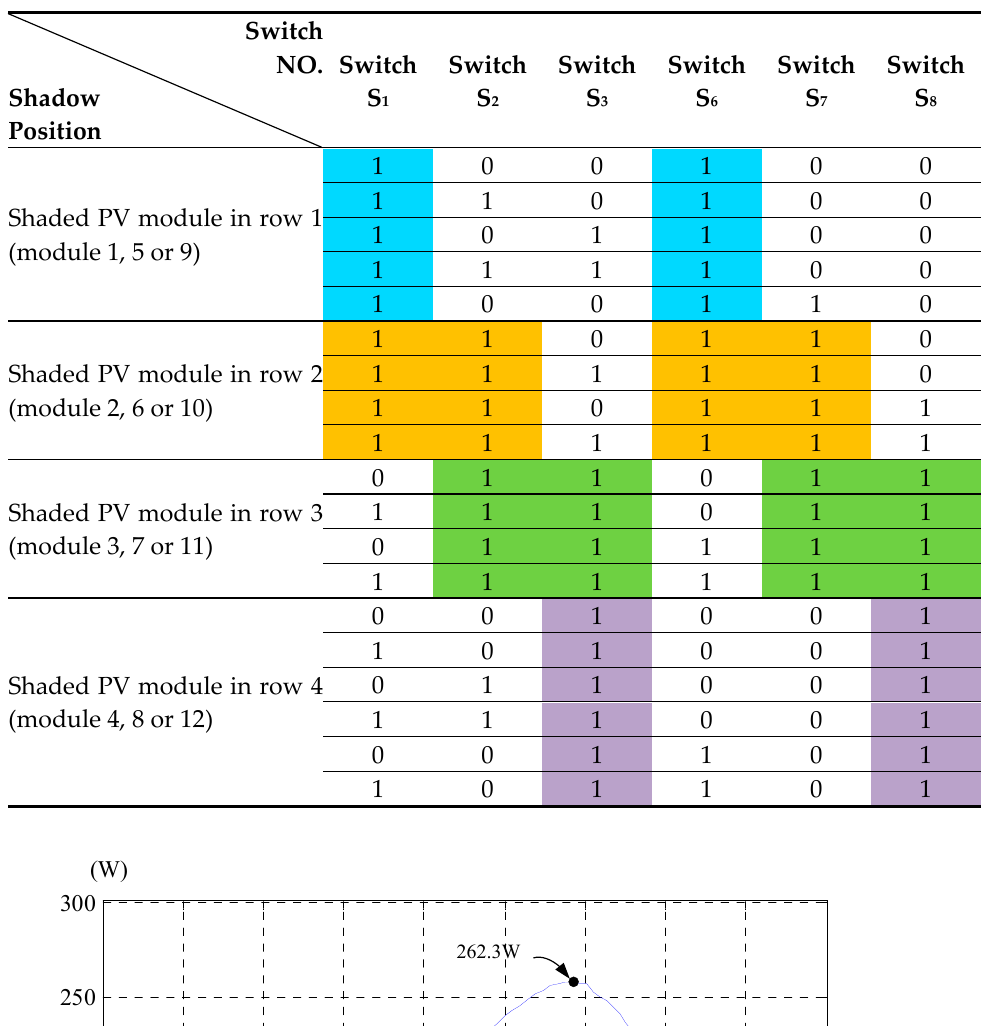
Table 2. Optimized configurations for different shaded cases.